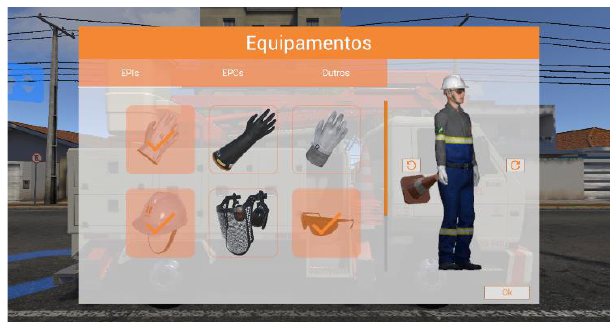
Figure 11. Inventory screen to select PPE, CPE and other equip-